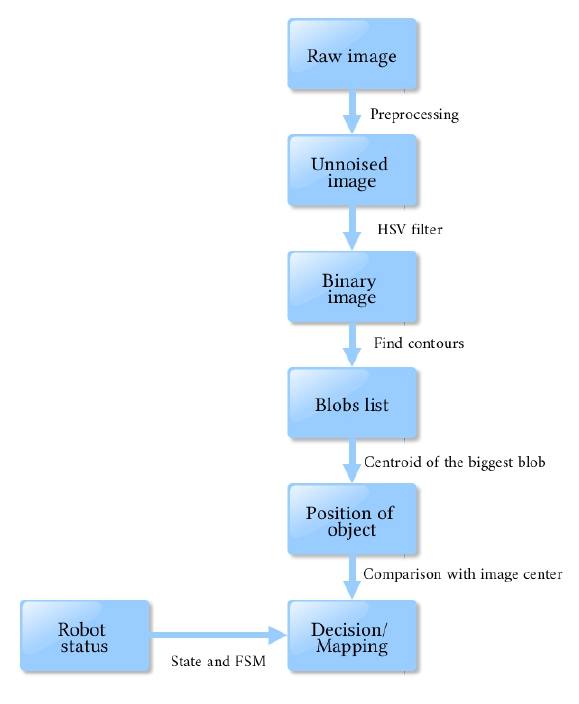
Figure 5. Data processing